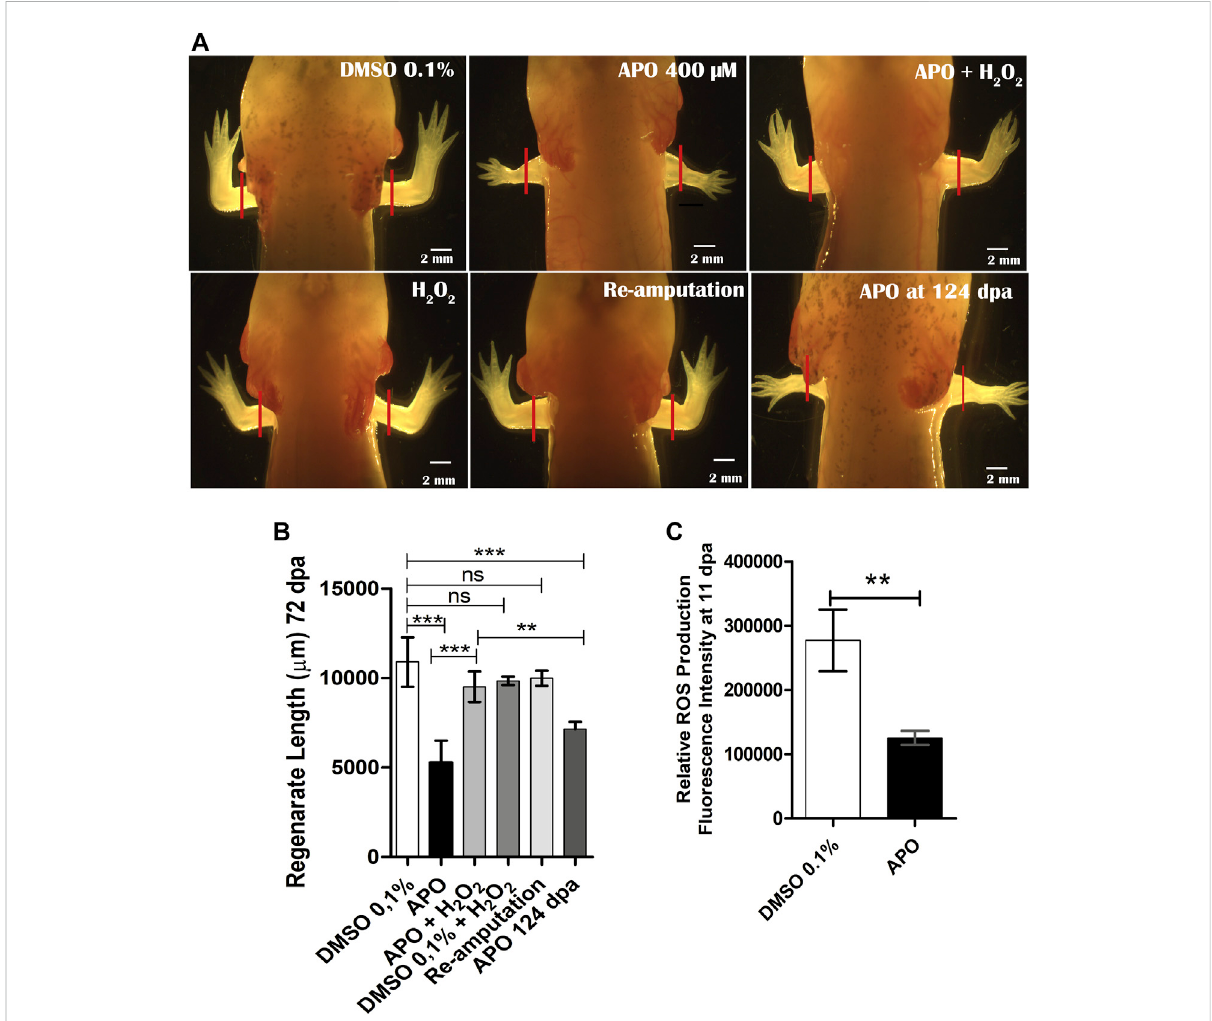
FIGURE 2 Blocking ROS production by apocynin affects limb regeneration in A. mexicanum . (A) , Representative images of animals exposed to different treatments compared to the control group in 0.1% DMSO. Defects generated by inhibition of NOX activity and rescue treatments (apocynin 400 µM + H 2 O 2 ) are shown. Solid red lines represent the amputation plane. (B) , Quanti fi cation of regenerated limb size at 72 dpa. Apocynin-exposed group evaluatedat124 dpawasincluded.One-wayANOVAandpost-hocTukeywereperformedtocomparetheevaluatedgroups(n=10pergroup). (C) , Semi-quanti fi cation of ROS levels post-exposure to apocynin inhibitor ( n = 7). ROS levels decrease signi fi cantly under inhibitory treatment. Student ’ s t-test was performed to compare the two groups. Data are expressed as mean ± SEM. *** p < 0.001, ** p < 0.01, * p <